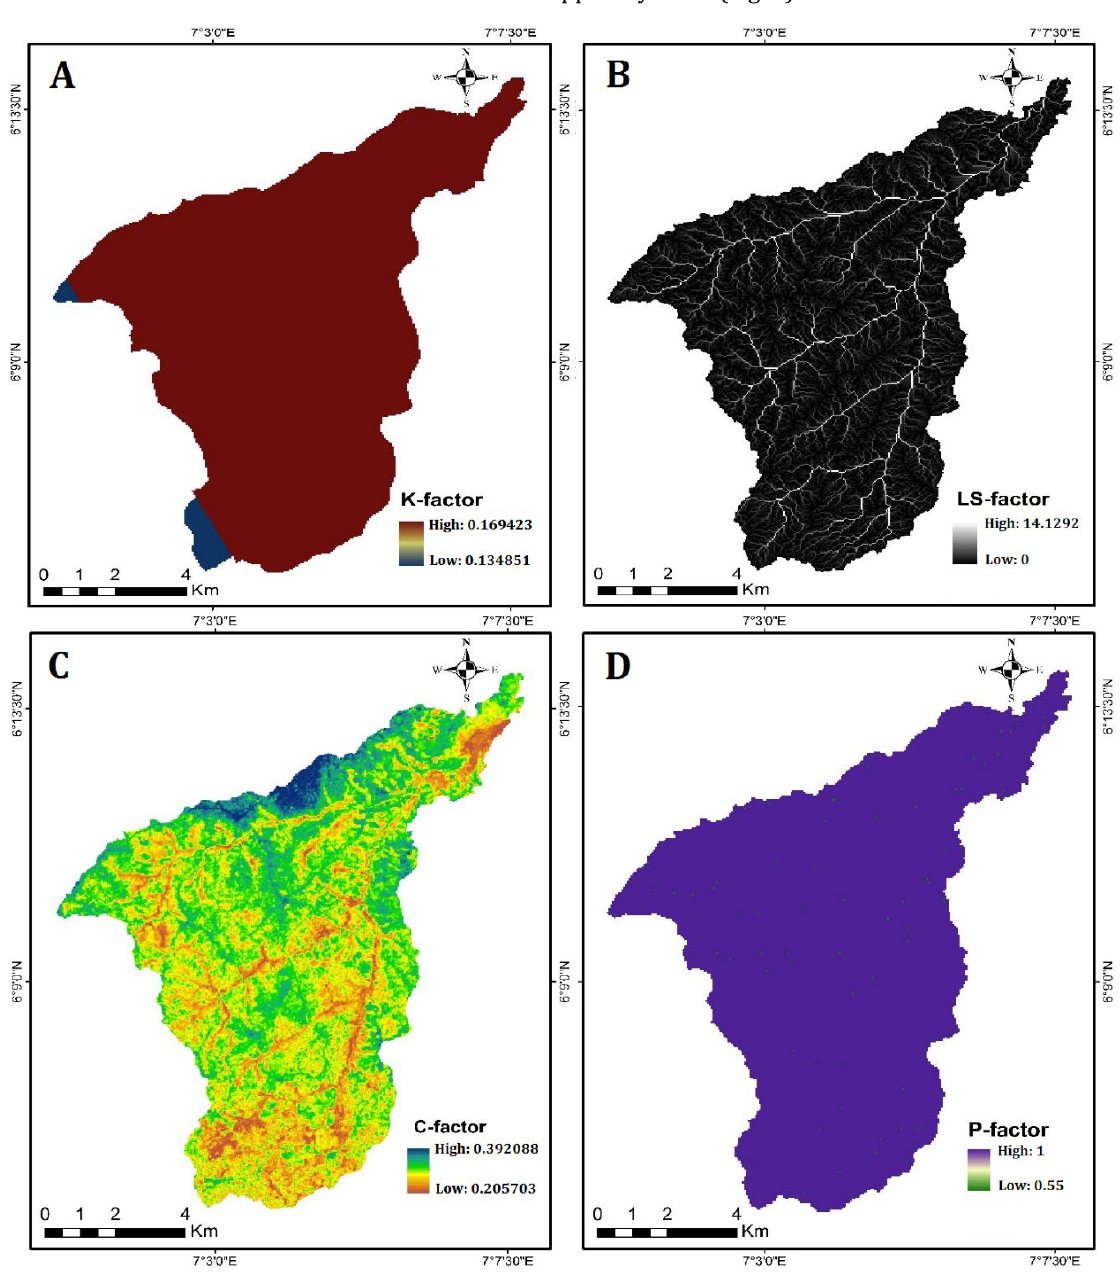
Figure 3. Spatial distribution of (A) Soil erodibility (K-factor) (B) Slope length and slope steepness (LS- factor) (C) Vegetation (C-factor), and (D) Support practice (P-factor) in Obibia River